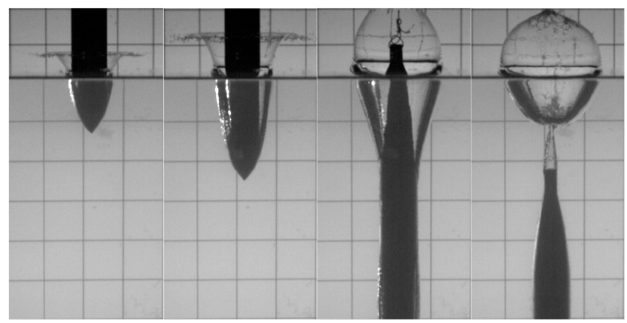
Figure 22. Cavity development and secondary closure.